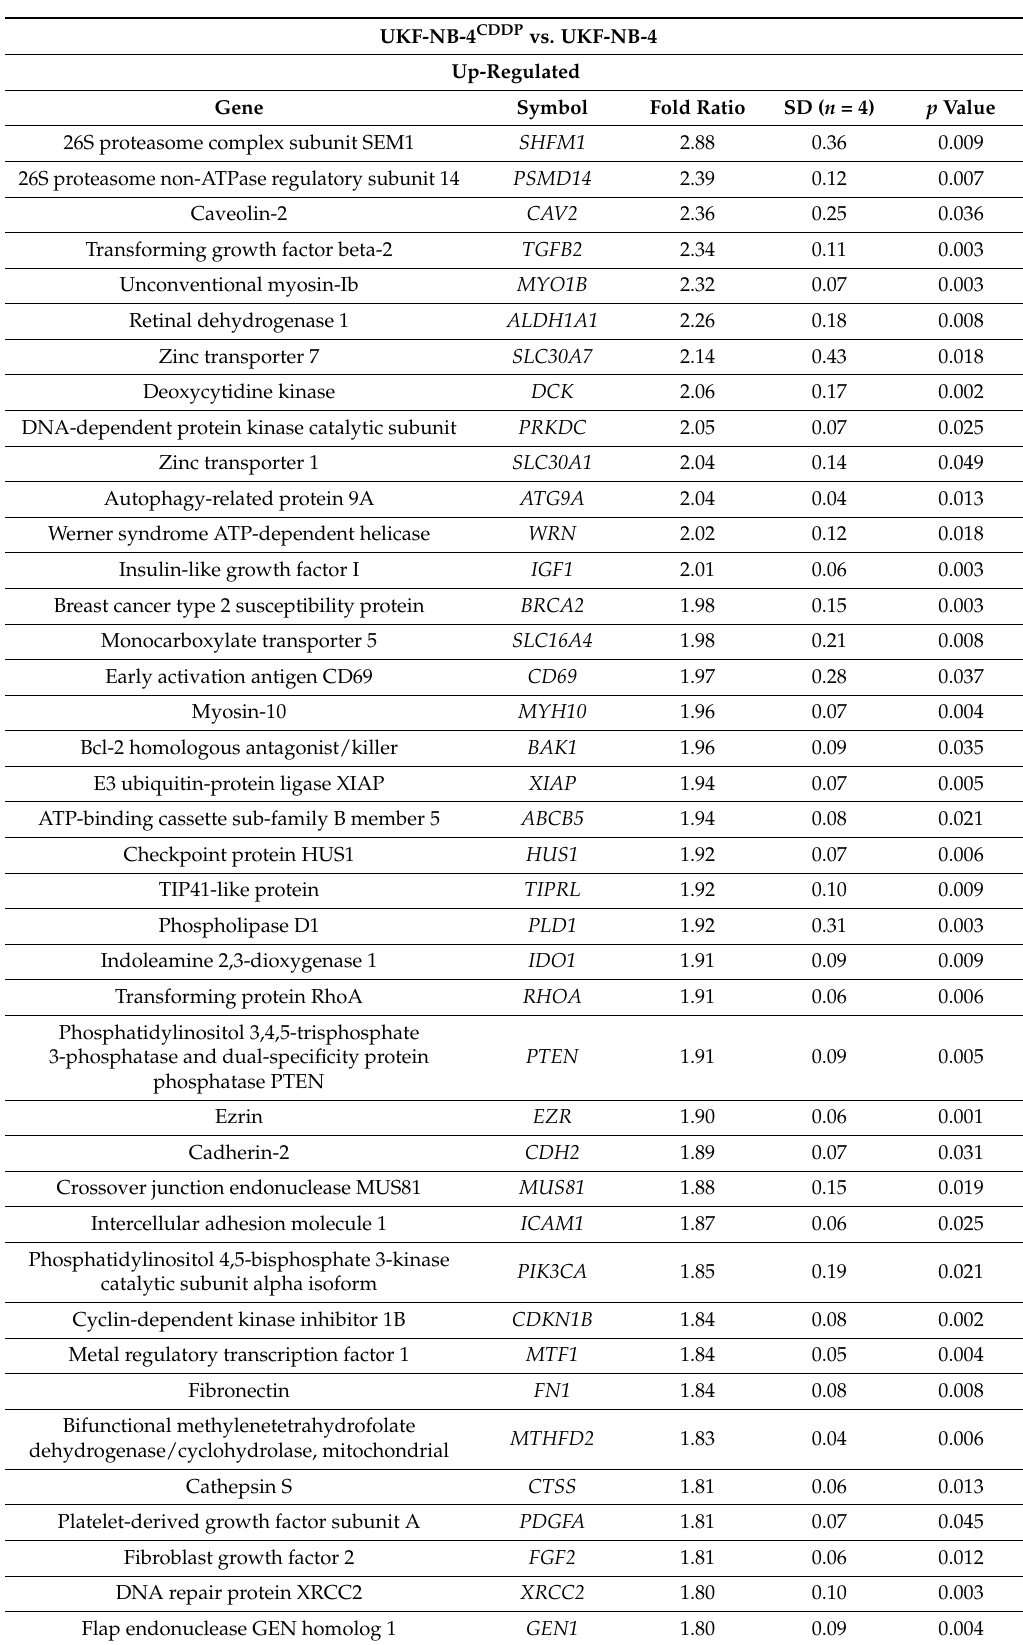
Table 1. List of genes up-regulated in UKF-NB-4 CDDP cells compared with parental UKF-NB-4 cell